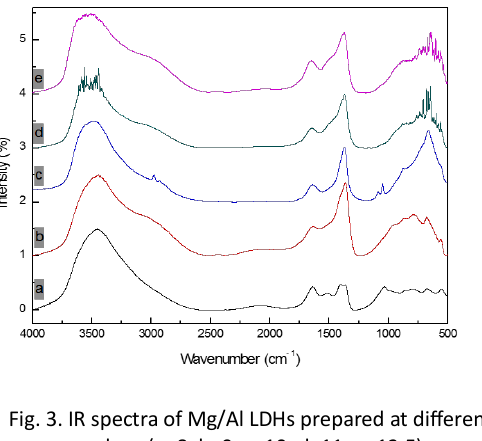
Fig. 3. IR spectra of Mg/Al LDHs prepared at different pH values (a: 8, b: 9, c: 10, d: 11, e: